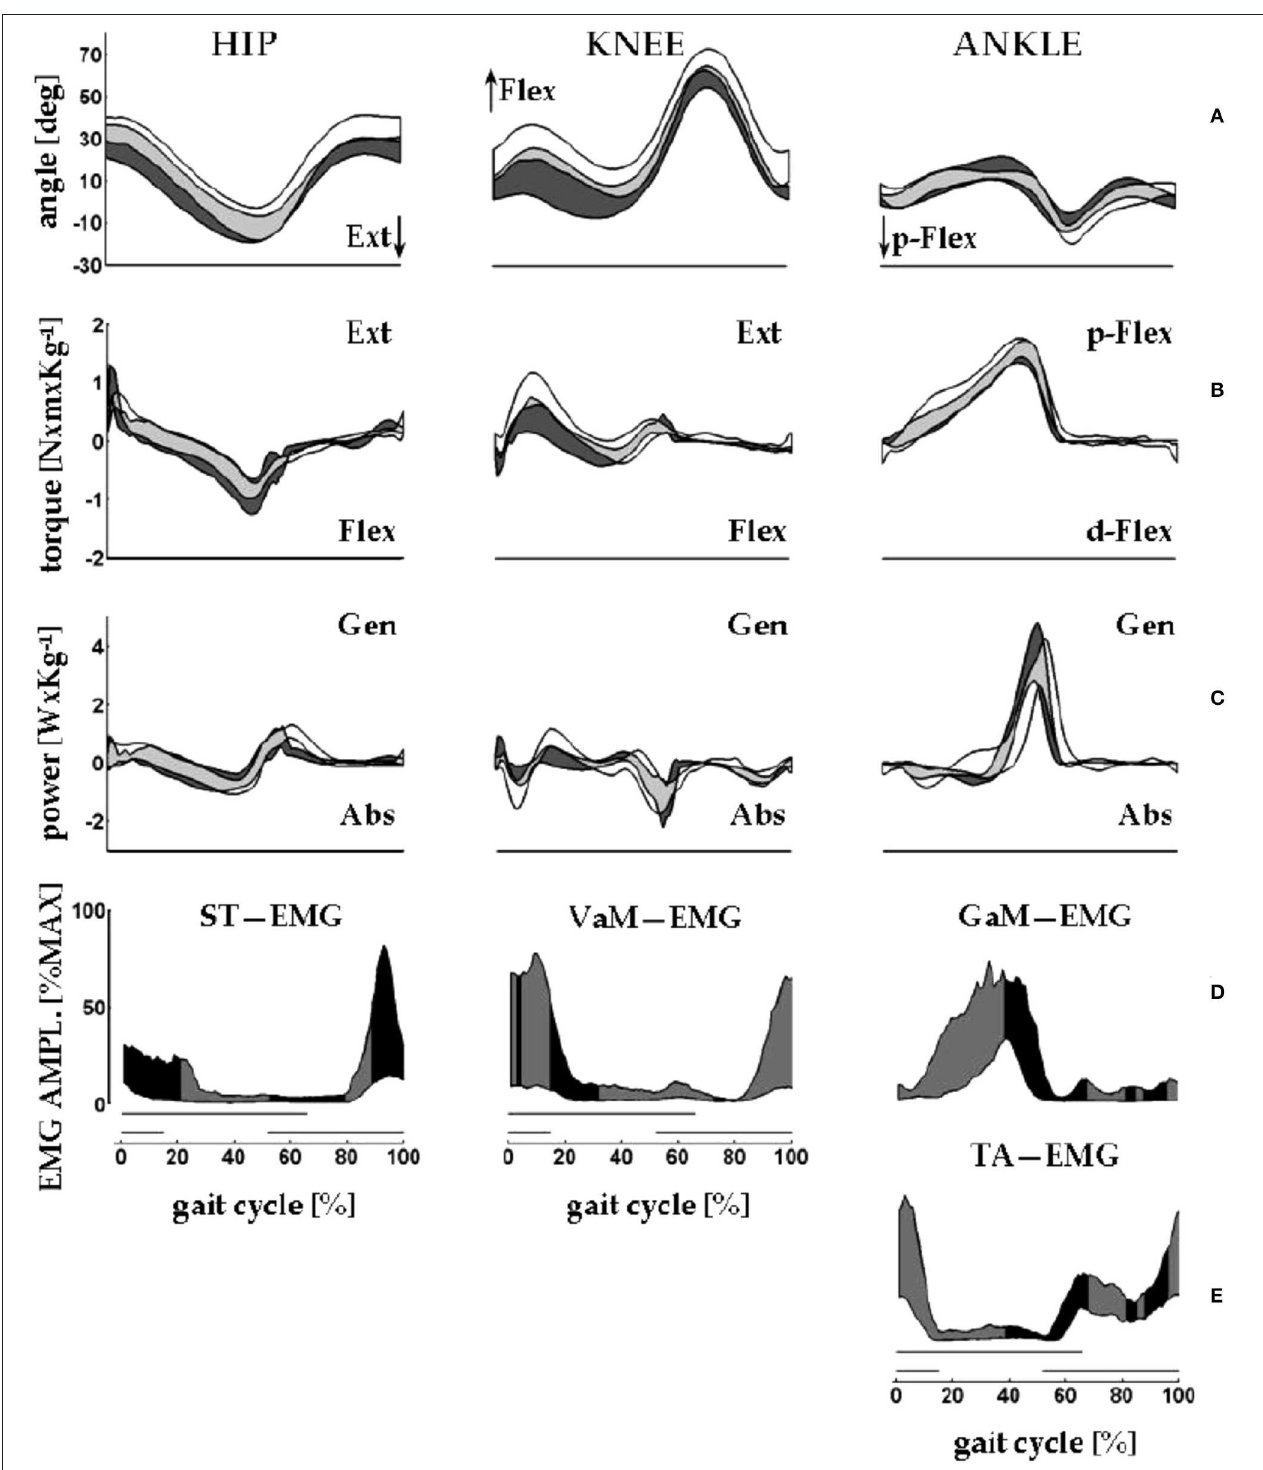
FIGURE 7 | An overview of measurements of lower limb motions from eight healthy adults (four men) during walking on a force-sensing treadmill. Average velocity: 1.32m s − 1 ; average cadence: 125 steps min − 1 . The x-axis gives the standardized stride time (data interpolated in 100% points; average absolute stride duration = 0.96s). Data from 10 strides were averaged. Here, the beginning and the end of the stride are made to coincide with the right foot strike. Dashes on the bottom of each column of panels mark the average duration of the stance phase of the stride under examination (thick upper line) and of the simultaneous contralateral stride (thin lower line). (A) From left to right, the y-axis shows sagittal rotations of hip, knee, and ankle joints. (B,C) From left to right, the y-axis shows the joint torques and